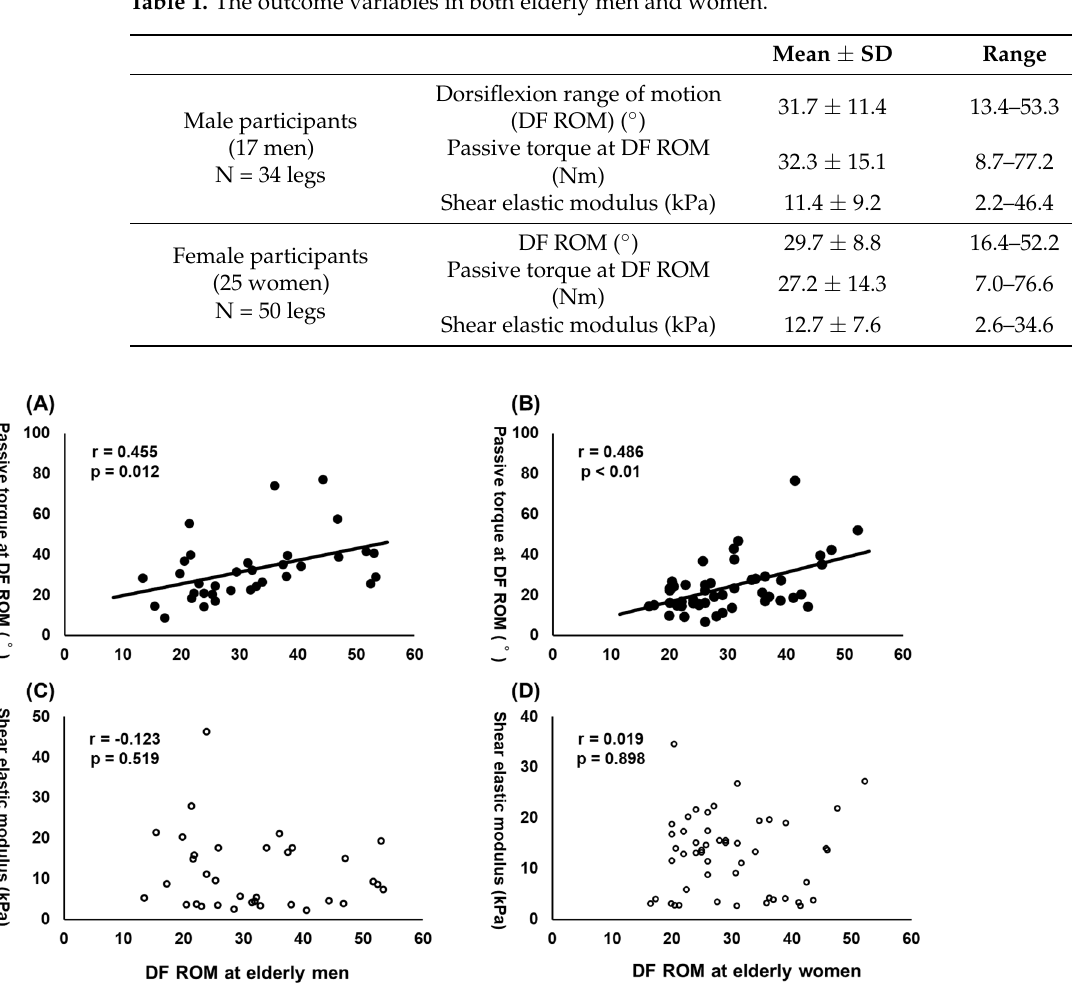
Table 1. The outcome variables in both elderly men and women.